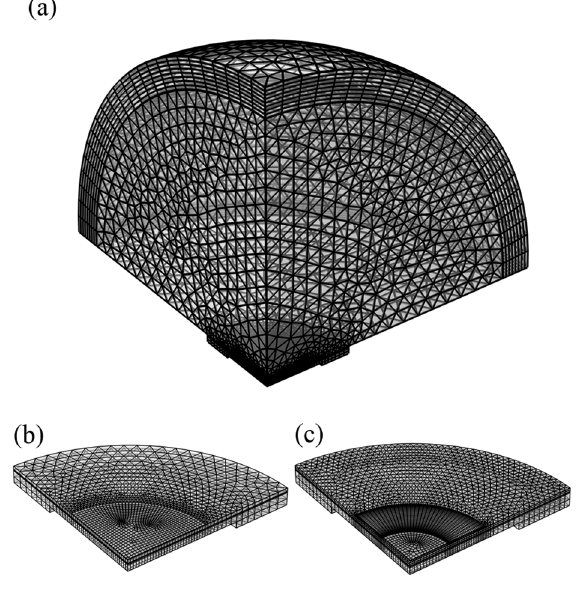
Figure 3. Mesh structure of ( a ) transducer model (including water domain and PML); ( b ) 1/4 block clamp structure array element; ( c ) 1/4 block optimized structure array element.